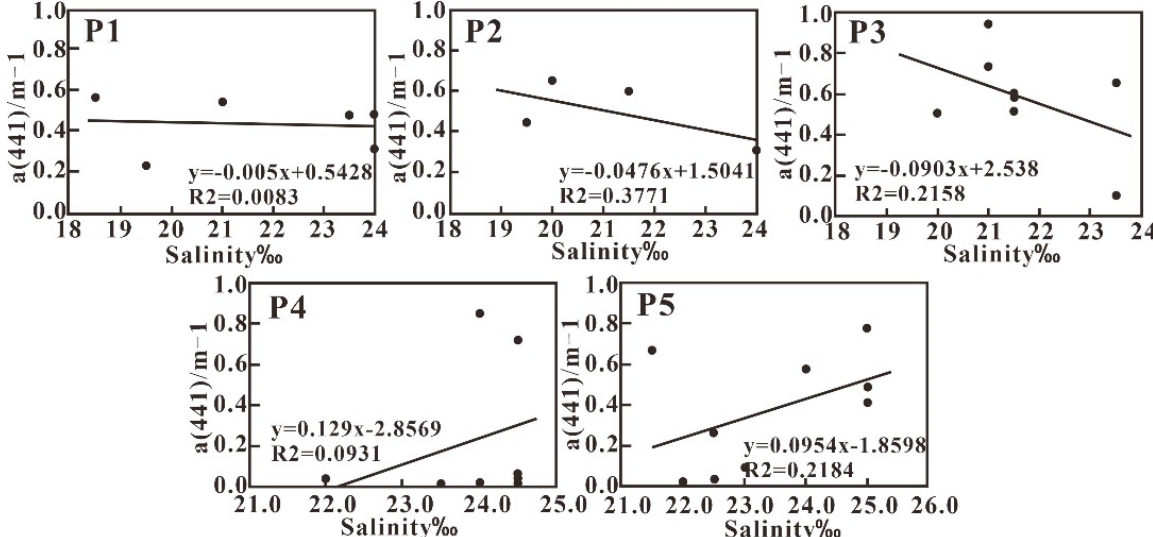
Figure 10. Variations in α (441) with salinity along the five transects.